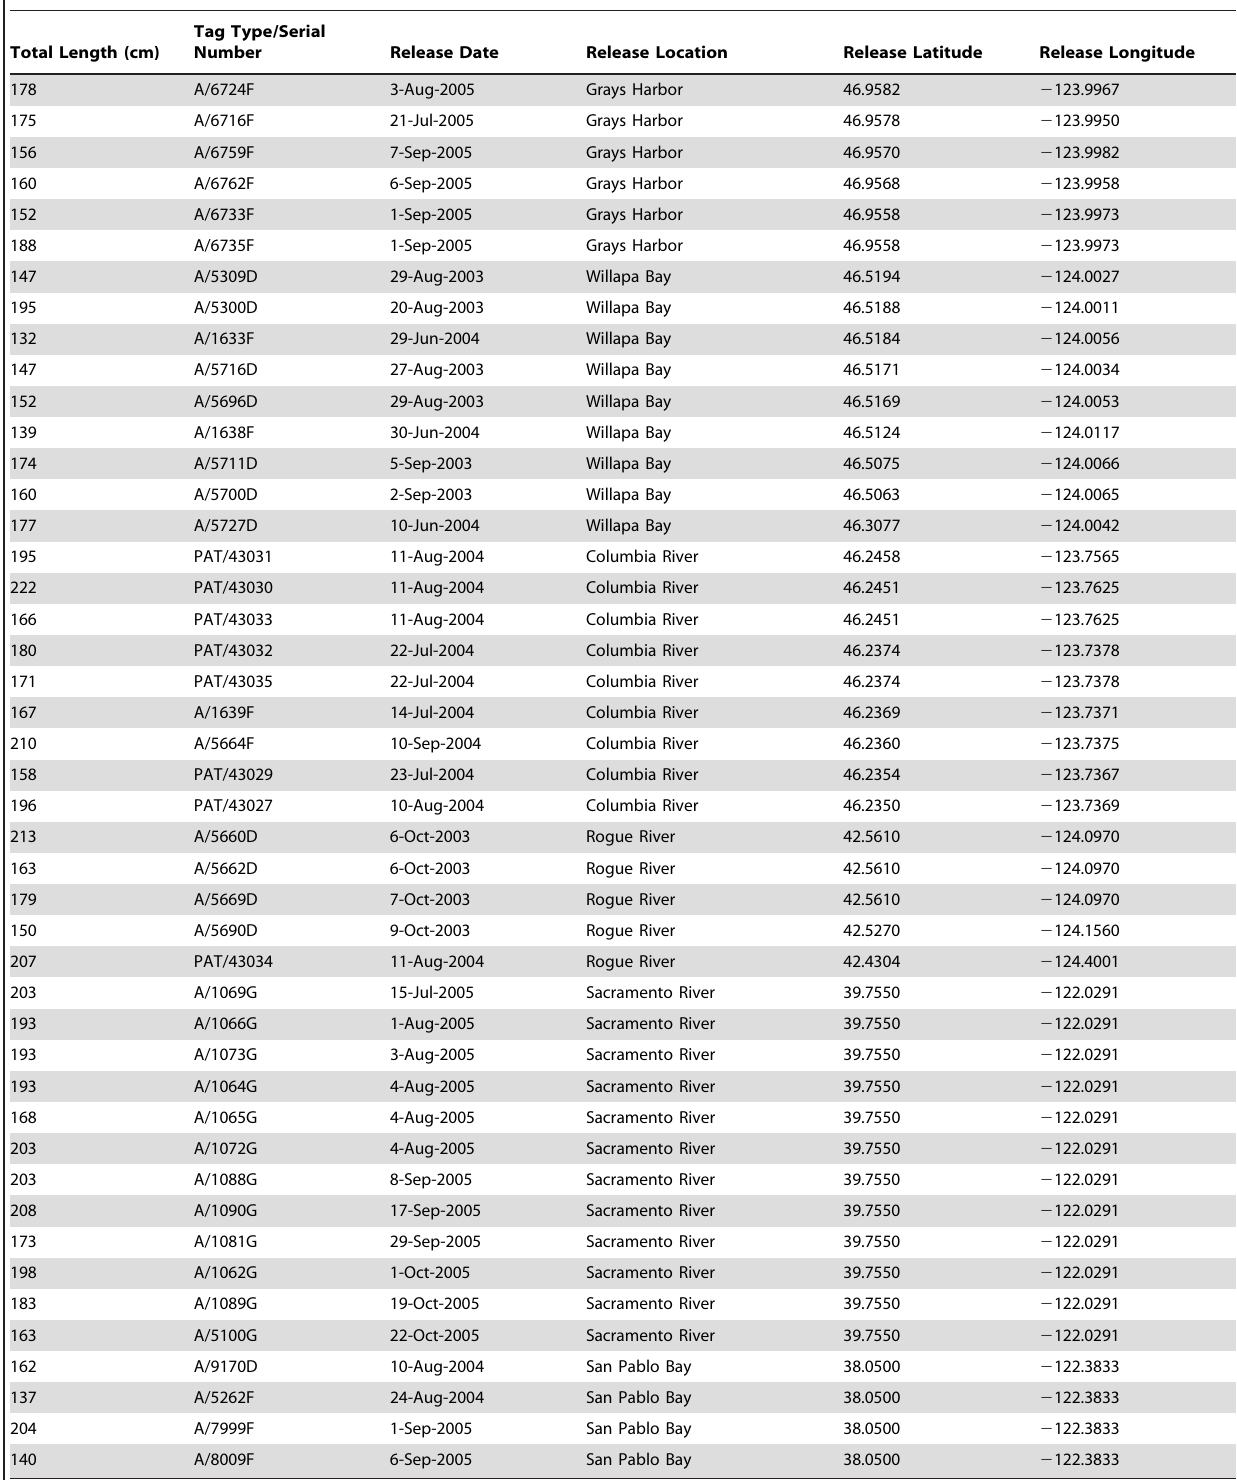
Table 1. Total length, release date, and release locations for 37 acoustically tagged sturgeon.